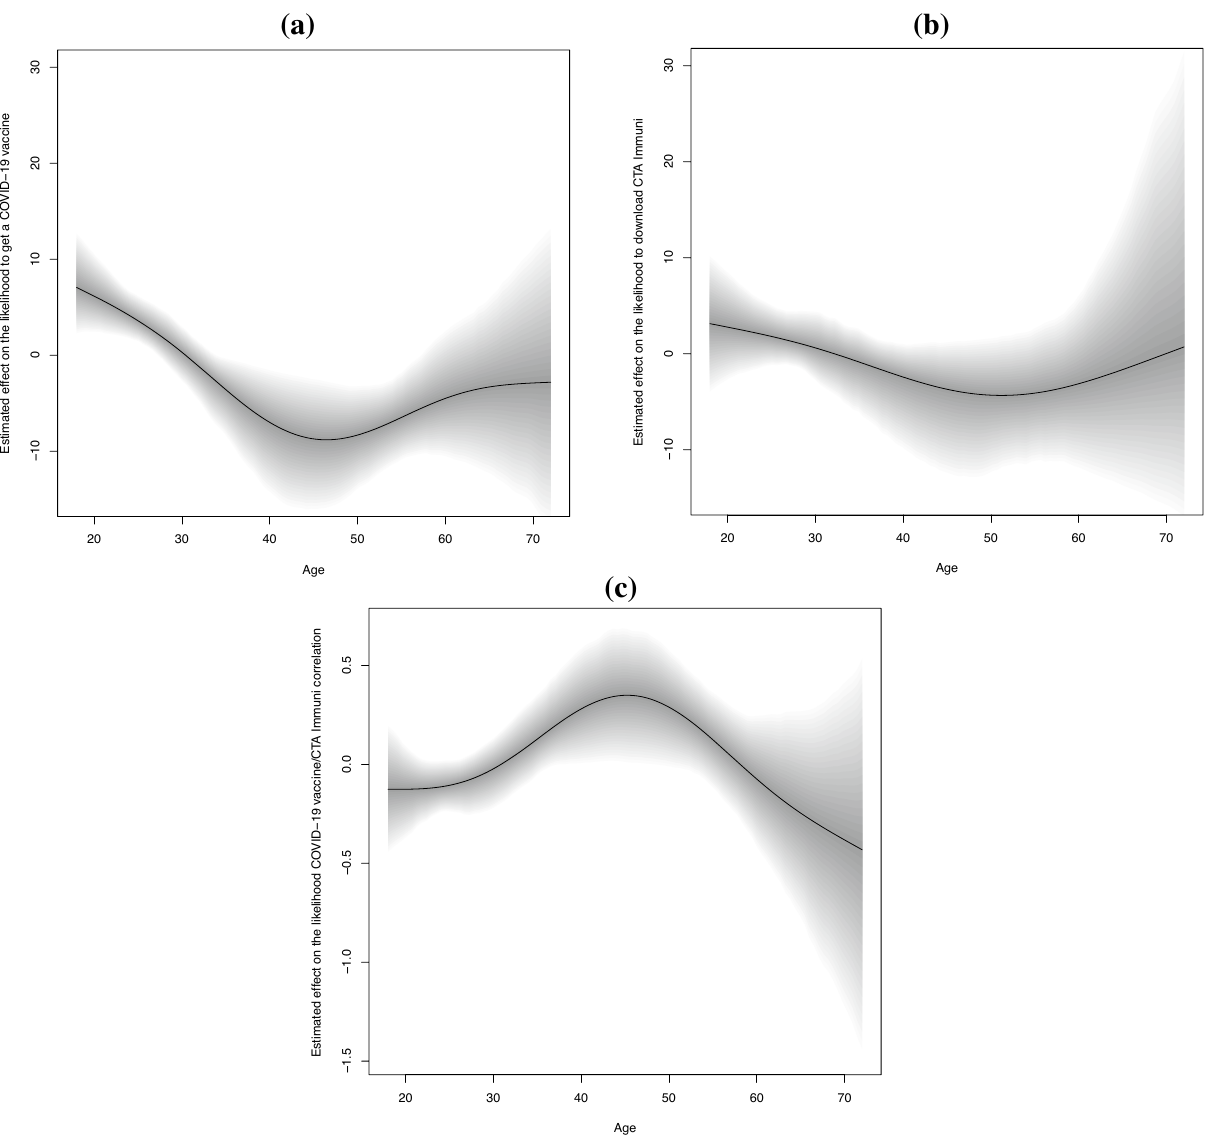
Figure 3. Adjusted effect of age estimated by a Bayesian Bivariate Gaussian regression model for the position parameter ( µ 1 and µ 2 ) of the score of likelihood to get a COVID-19 vaccine ( a ) and to download CTA Immuni ( b ), and their correlation (rhogit( ρ ), ( c